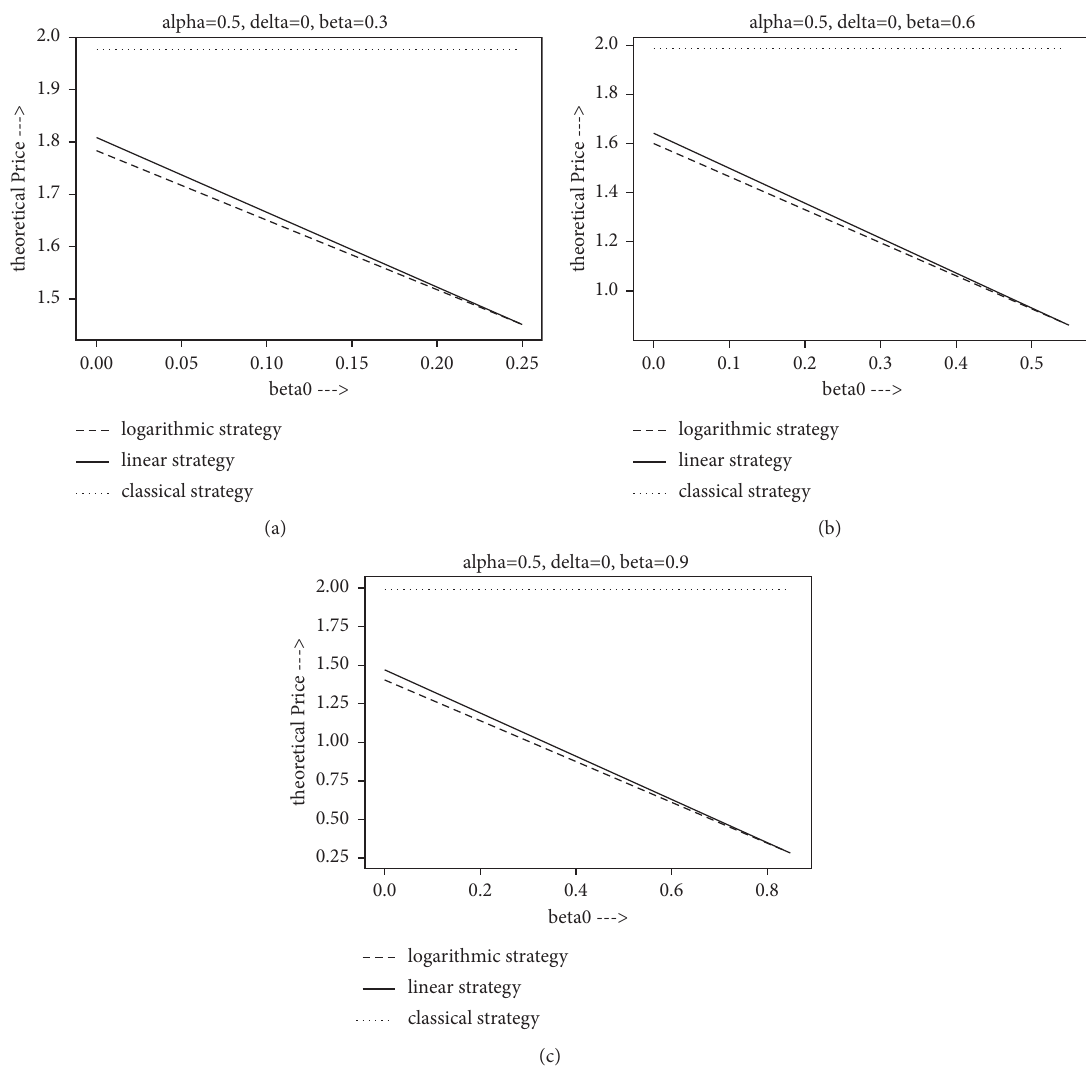
Figure 5: The theoretical price as a function of β